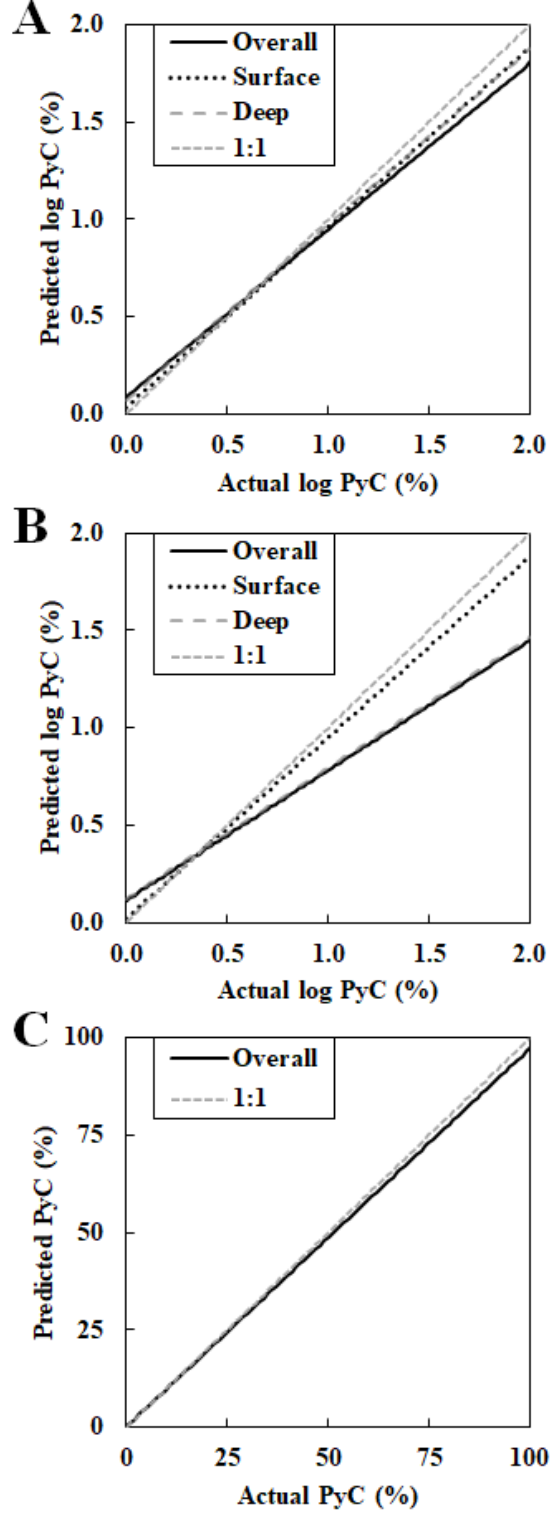
Figure 4. Plots showing predicted versus actual slopes of all models on the log scale, with the 1:1 (y = x) line in dotted grey, for the peak fitted (A) direct polarisation, (B) cross polarisation and (C) PLS direct polarisation models. Model statistics are as presented in Table